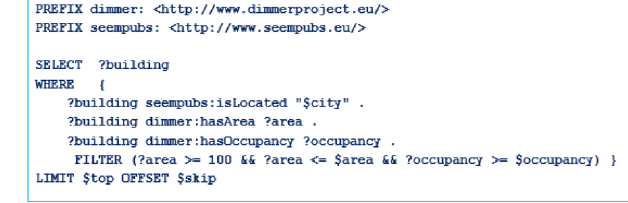
Figure 4. Ontology schema